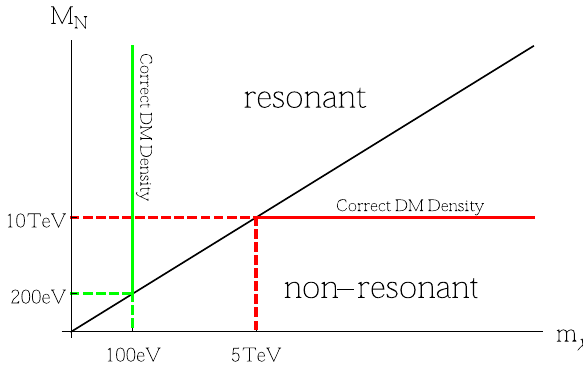
Fig. 3 Parameter space for y χ = y ν : the black line divides the plane spannedbytheDMmass m χ andthemediatormass M N intotwohalves. The upper (lower) half corresponds to the resonant (non-resonant) DM production regime. The red and green line show where the correct amountofDMisproducedforthenon-resonantandtheresonantregime, respectively. In the non-resonant regime, producing the correct density only depends on the mediator mass, whereas it only depends on the DM mass in the resonant region